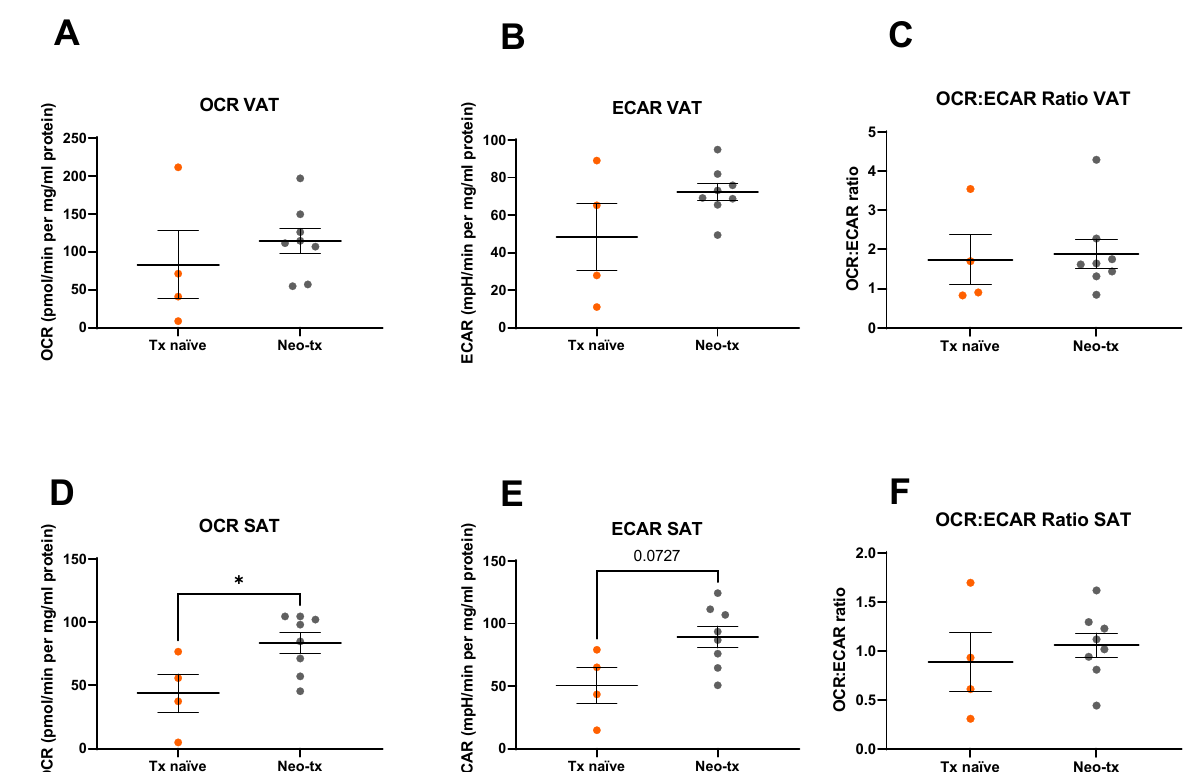
Figure 3. Metabolic analysis of visceral adipose tissue (VAT) and subcutaneous adipose tissue (SAT) by treatment modality. There was no significant difference in ( A ) oxygen consumption rate (OCR), ( B ) extracellular acidification rate (ECAR), or ( C ) OCR:ECAR ratio in VAT between the treatment-naïve cohort and those receiving cytotoxic neoadjuvant therapy. ( D ) OCR was significantly higher in SAT in patients receiving cytotoxic neoadjuvant therapy compared to the treatment-naïve cohort. ( E ) There was no significant difference in ECAR in SAT between patients receiving cytotoxic neoadjuvant therapy compared to the treatment-naïve cohort. ( F ) OCR:ECAR ratio was not significantly different in SAT between the treatment-naïve cohort and those receiving cytotoxic therapy. Statistical analysis was performed using a Mann–Whitney U-test. All data expressed as mean ± SEM. n = 4 for treatment-naïve (tx-naïve) cohort, n = 8 for cytotoxic neoadjuvant therapy (neo-tx) cohort. * p < 0.05.